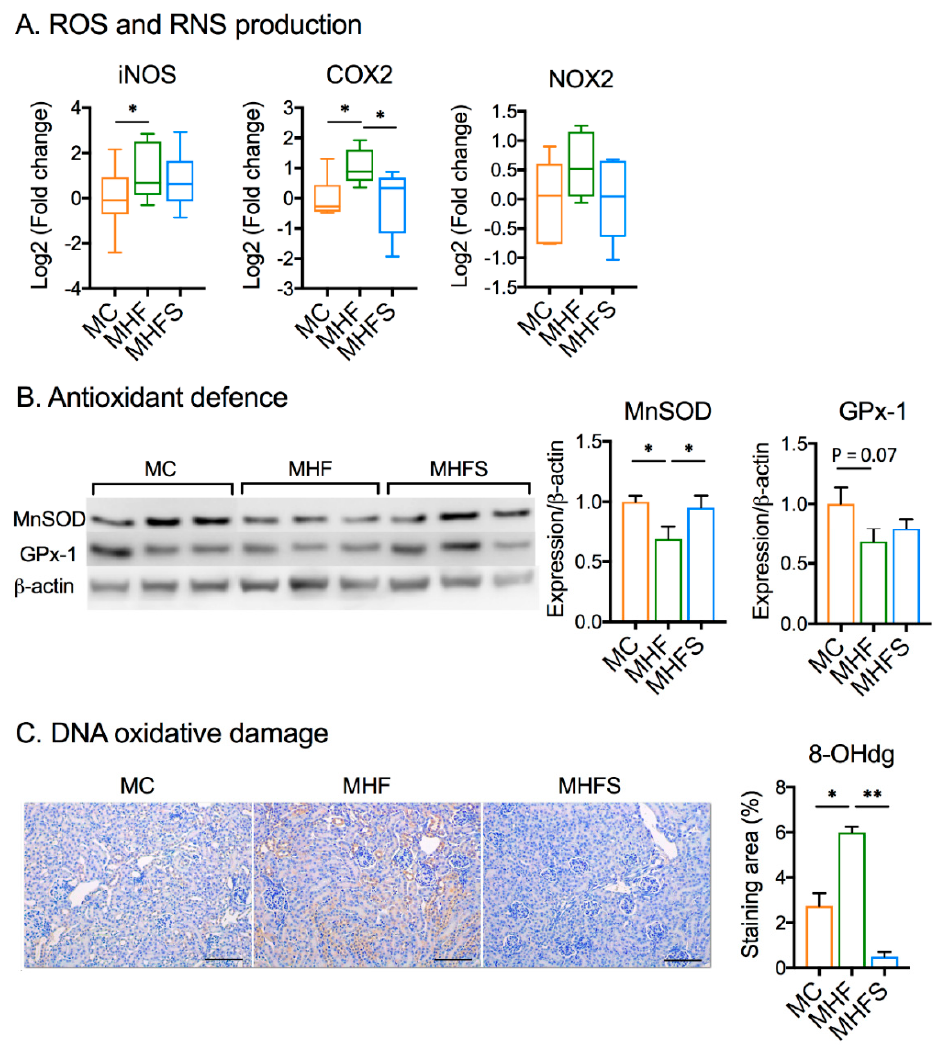
Figure 3. SIRT1 overexpression attenuates renal oxidative stress in offspring born to obese dams. ( A ) mRNA expression of oxidative stress markers ( n = 6). ( B ) Protein expression of antioxidant enzymes. ( C ) Immunohistochemistry (IHC) staining and quantification of 8-hydroxy-2'-deoxyguanosine (8-OHdG) ( n = 6). Data are presented as mean ± SEM or box plot (min to max, the central lines indicate